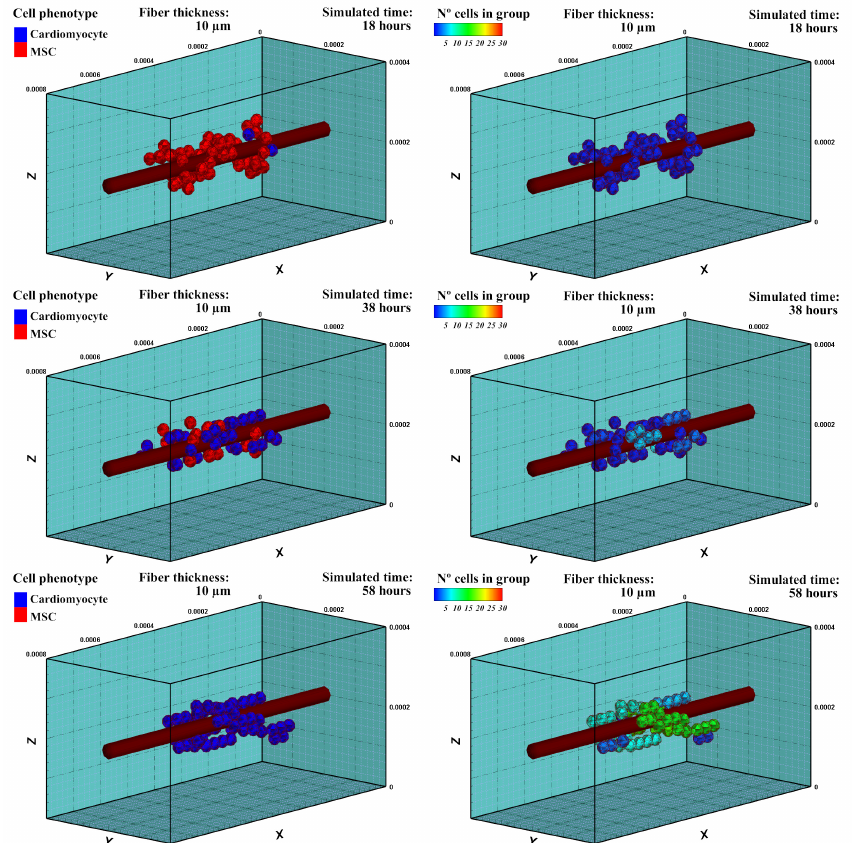
Figure 7. Cell phenotype ( left ) and group formation ( right ). Cell differentiation, induced by the mechanical stimulus, has been evaluated in an ECM of 20 kPa stiffness. After 18 h of stimulation, cells start differentiation into CMs. As cells adopt cardiac phenotype, groups with stable cell junctions start to form. After 38 h, groups of 3–5 cells can be observed. After 58 h, all the cells are differentiated into the cardiac phenotype. The number of cells of the groups are continually increasing with time (see also Supplementary Material: